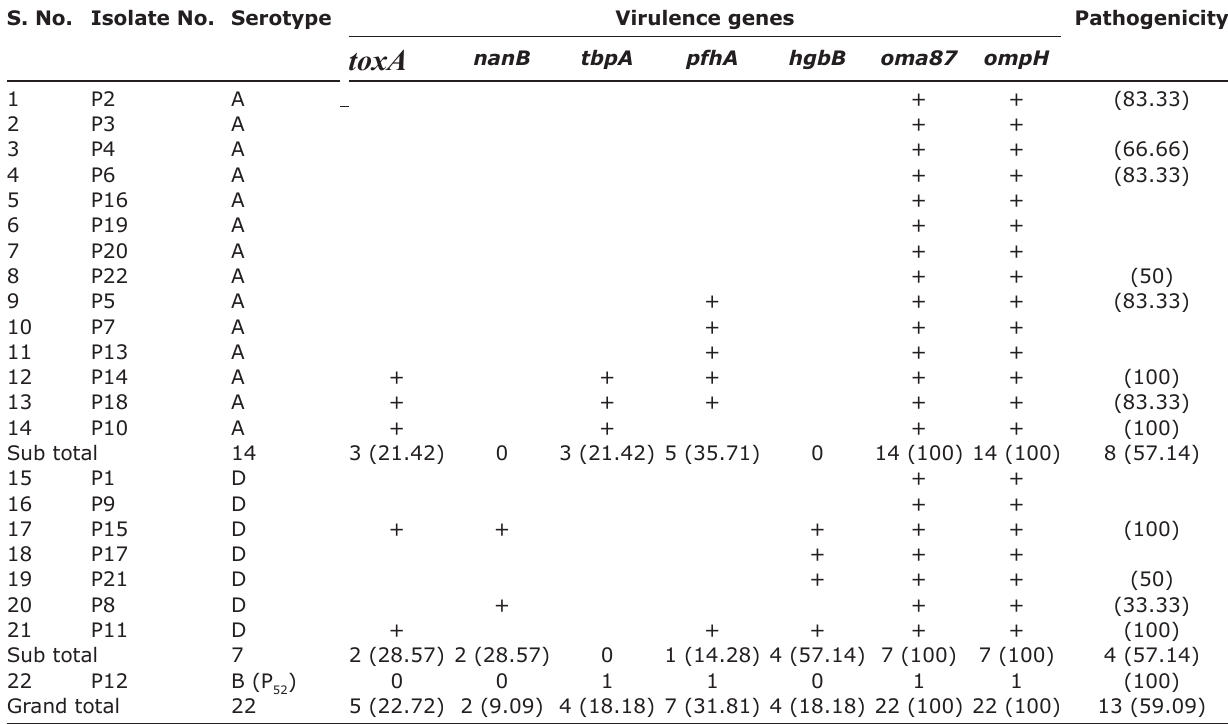
Table-3: Virulence-associated gene detection in different serotypes of swine Pasteurella multocida by PCR and their pathogenicity in mice. S. No. Isolate No.